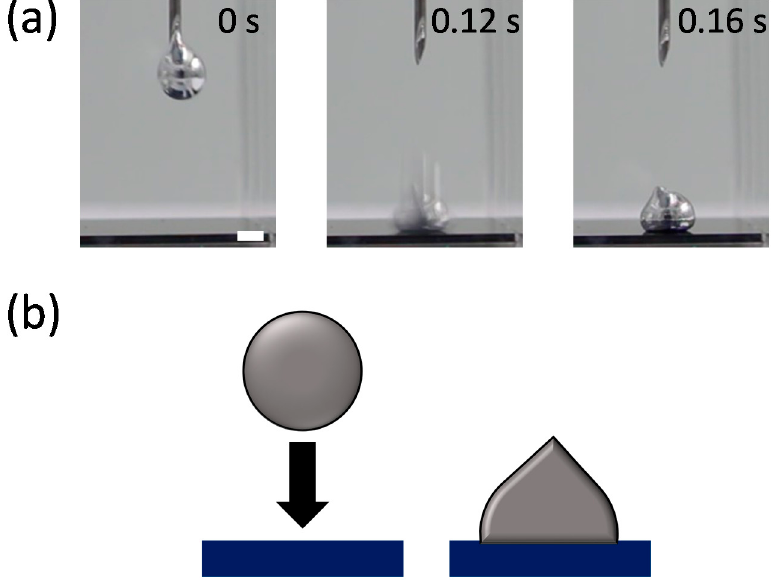
Figure 4. ( a ) Video snapshots of the EGaIn droplet impacting a Si wafer in hexane at 20 °C. Scale bar is 2 mm. ( b ) Schematic of the “adhesion” behavior of the EGaIn droplet in ( a ).